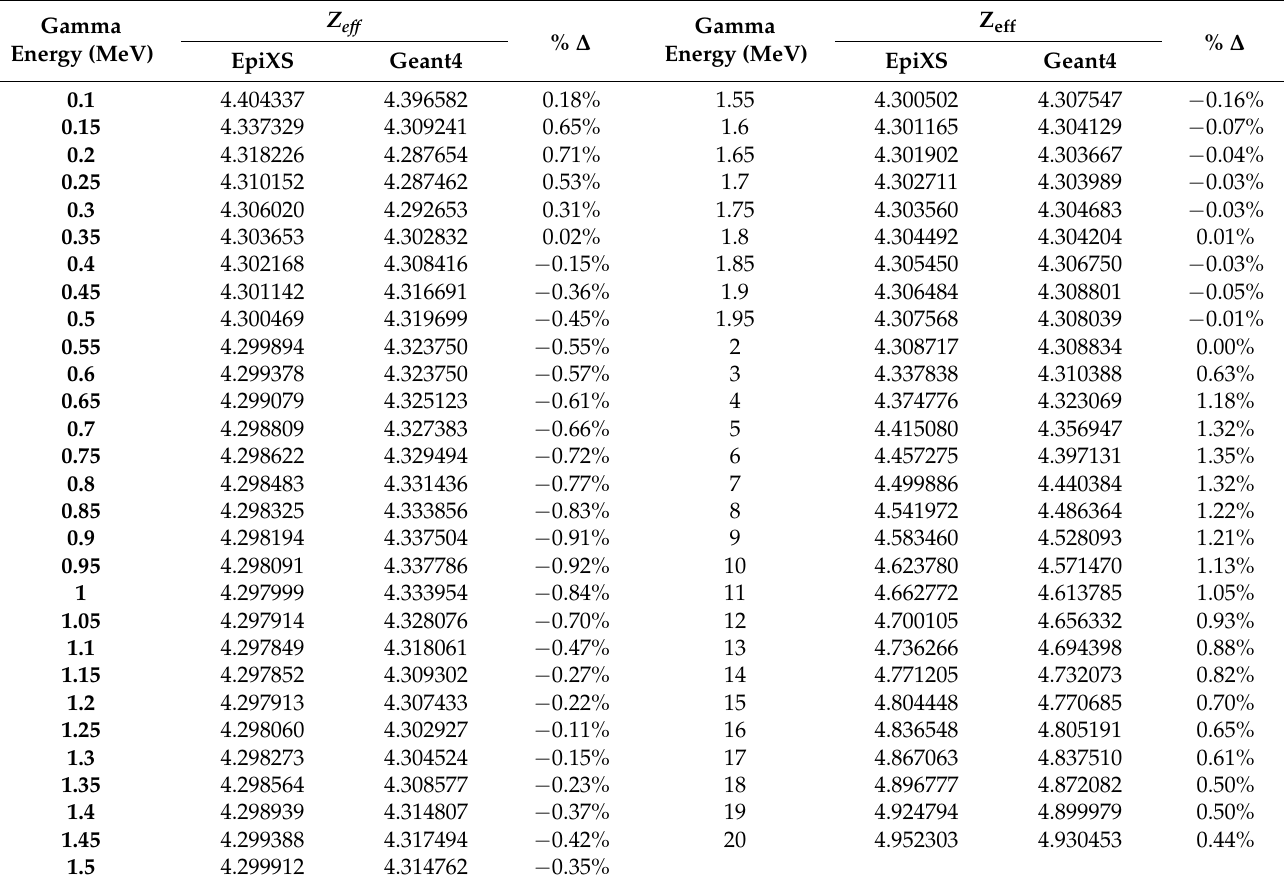
Table 4. The effective atomic numbers of PSU in the investigated energy range.